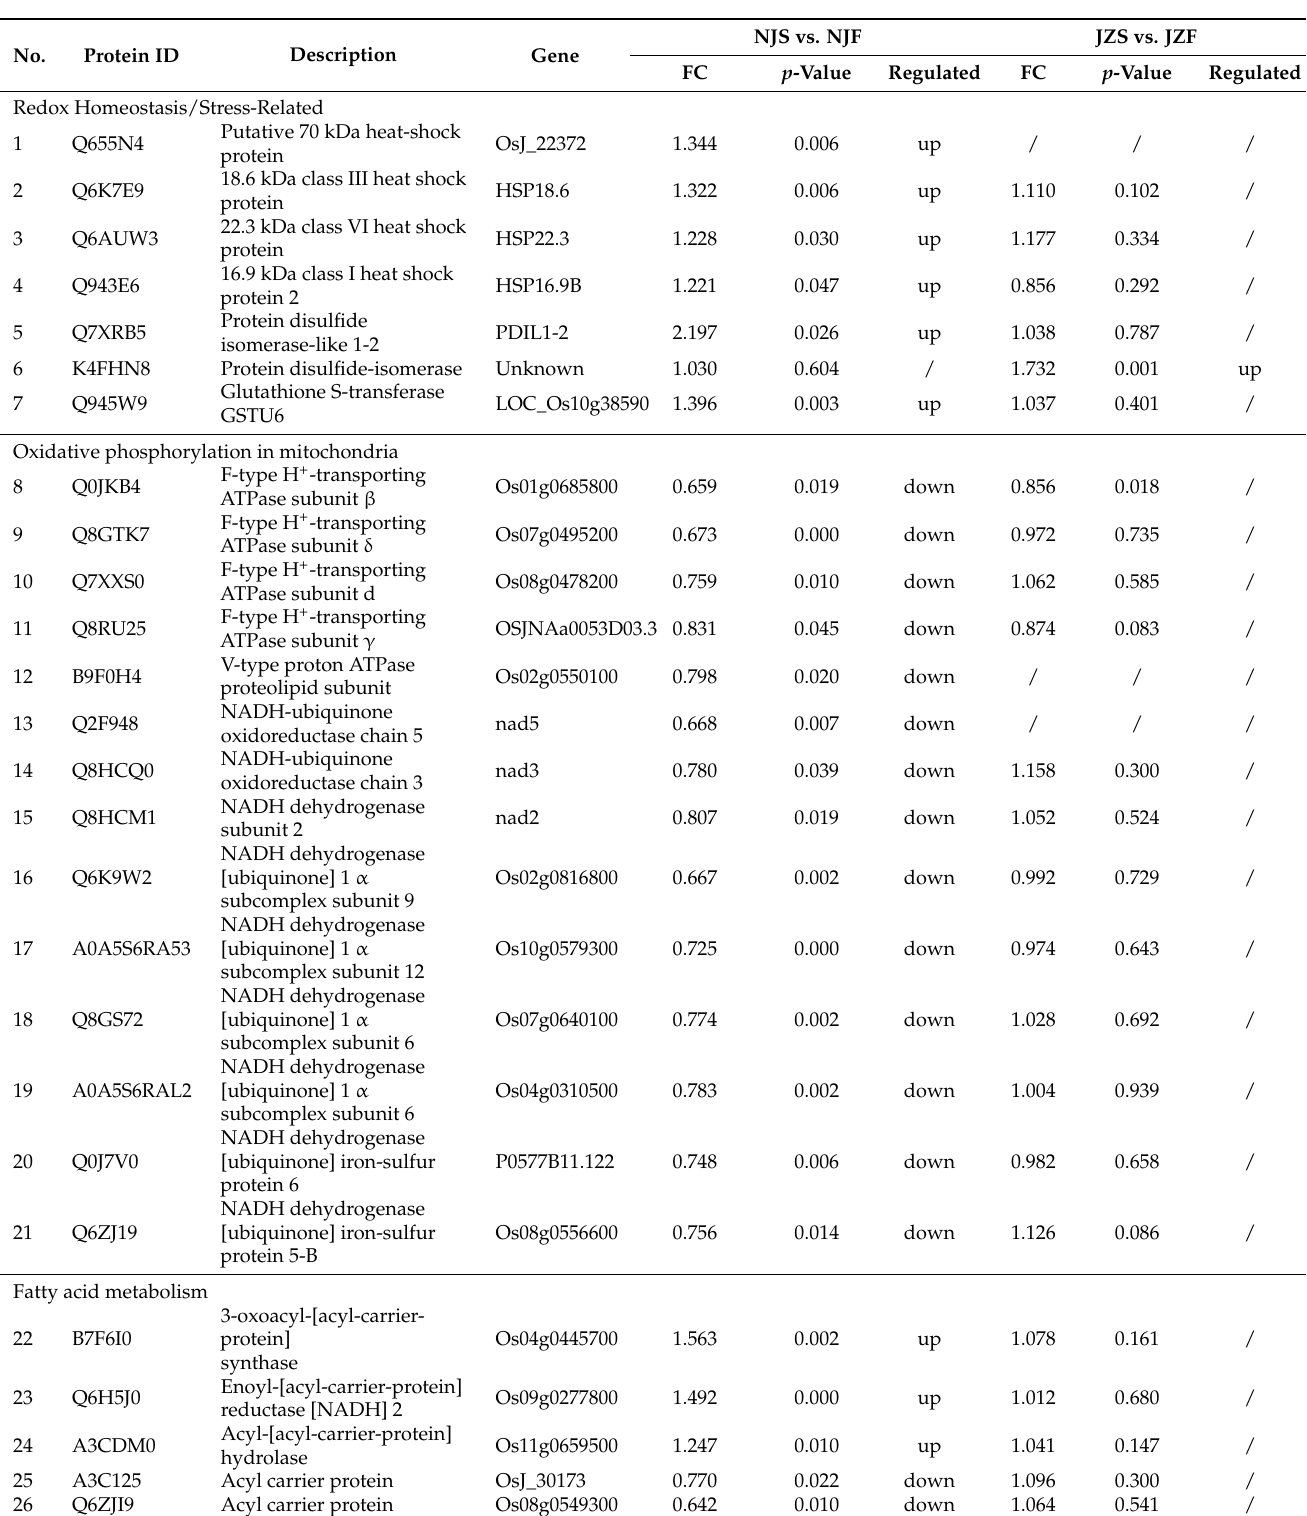
Table 3. Partial DEPs related to quality deterioration in two varieties during